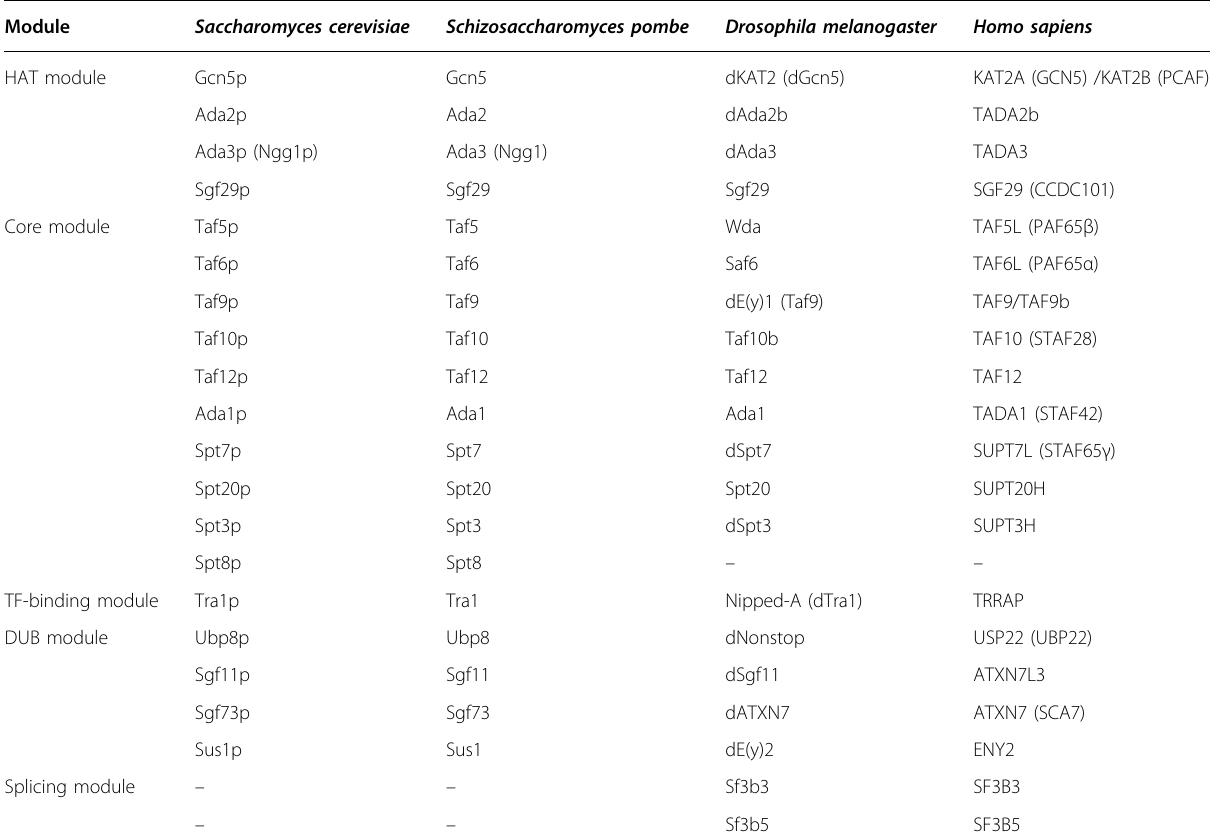
Table 1 Subunits of SAGA in four representative model organisms.